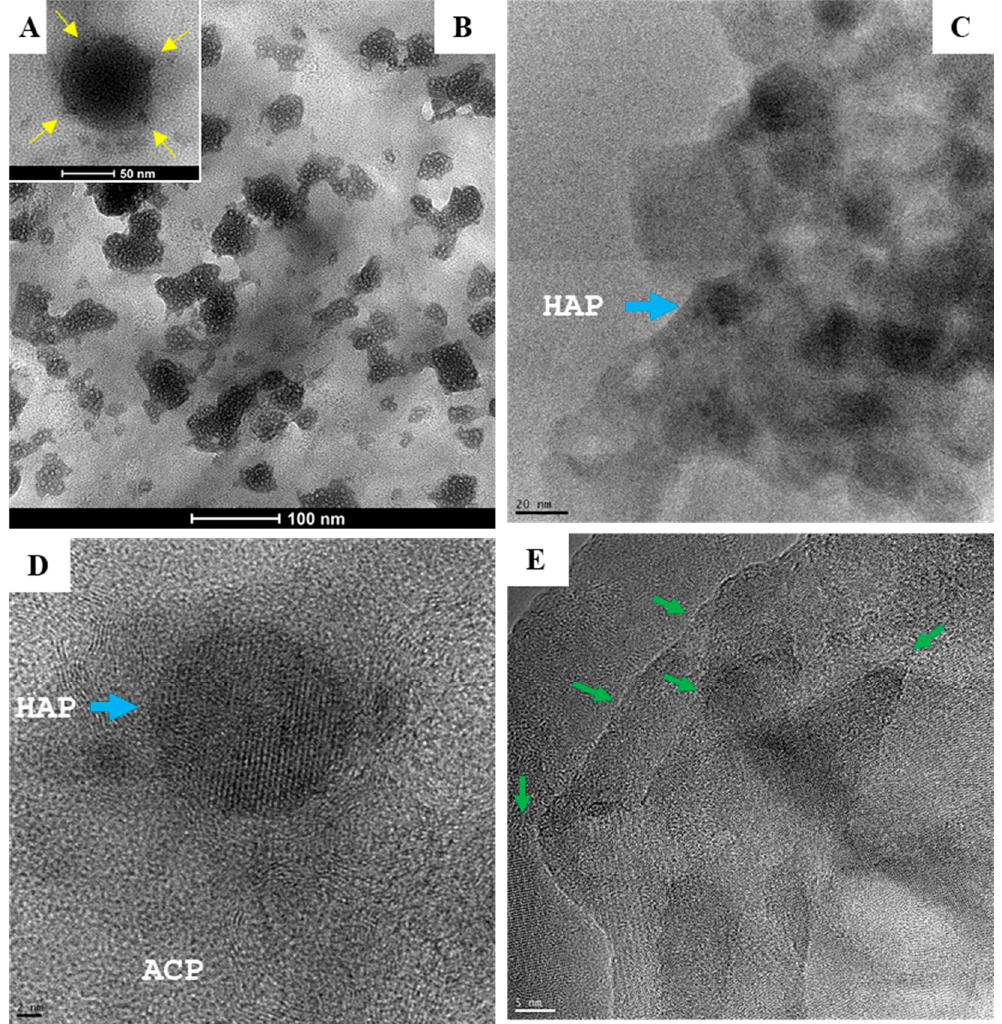
Figure 4. Electron micrographs depict two types of amorphous calcium phosphate (ACP) precursors. ( A ) Large spherical particles (50–100 nm) with remarkable electron-dense areas (inset, yellow arrows) are typical of chemically synthetized nanoparticles (scale bar = 50 nm). ( B – D ) Biologically synthetized agglomerates of much smaller granules composed of hydroxyapatite (HAP) crystallites (5–10 nm; blue arrow) produced by human cells grown for 7 days in MEM α / 10% FBS with α GP (2 mM) and CIP (1 U / mL). Scale bars: ( B ) = 100 nm; ( C ) = 20 nm; ( D ) = 2 nm. ( E ) Boundaries (green arrows) formed between HAP grains (scale bar = 5 nm).